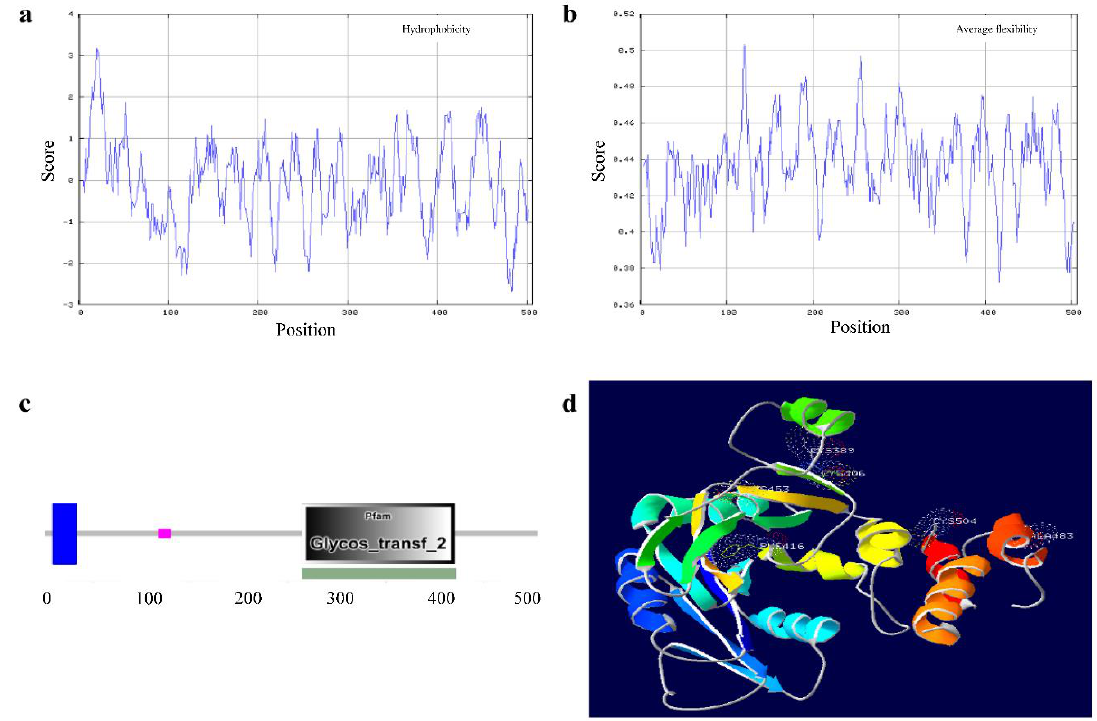
Figure 3. Feature and structure prediction of the ovine B4GALNT2 protein. ( a ) Hydrophobicity analysis of the B4GALNT2 protein. ( b ) Average flexibility index of the B4GALNT2 protein. ( c ) Predicted conservative domains of the B4GALNT2 protein. ( d ) Prediction of partial sequence for B4GALNT2 in tertiary structures.